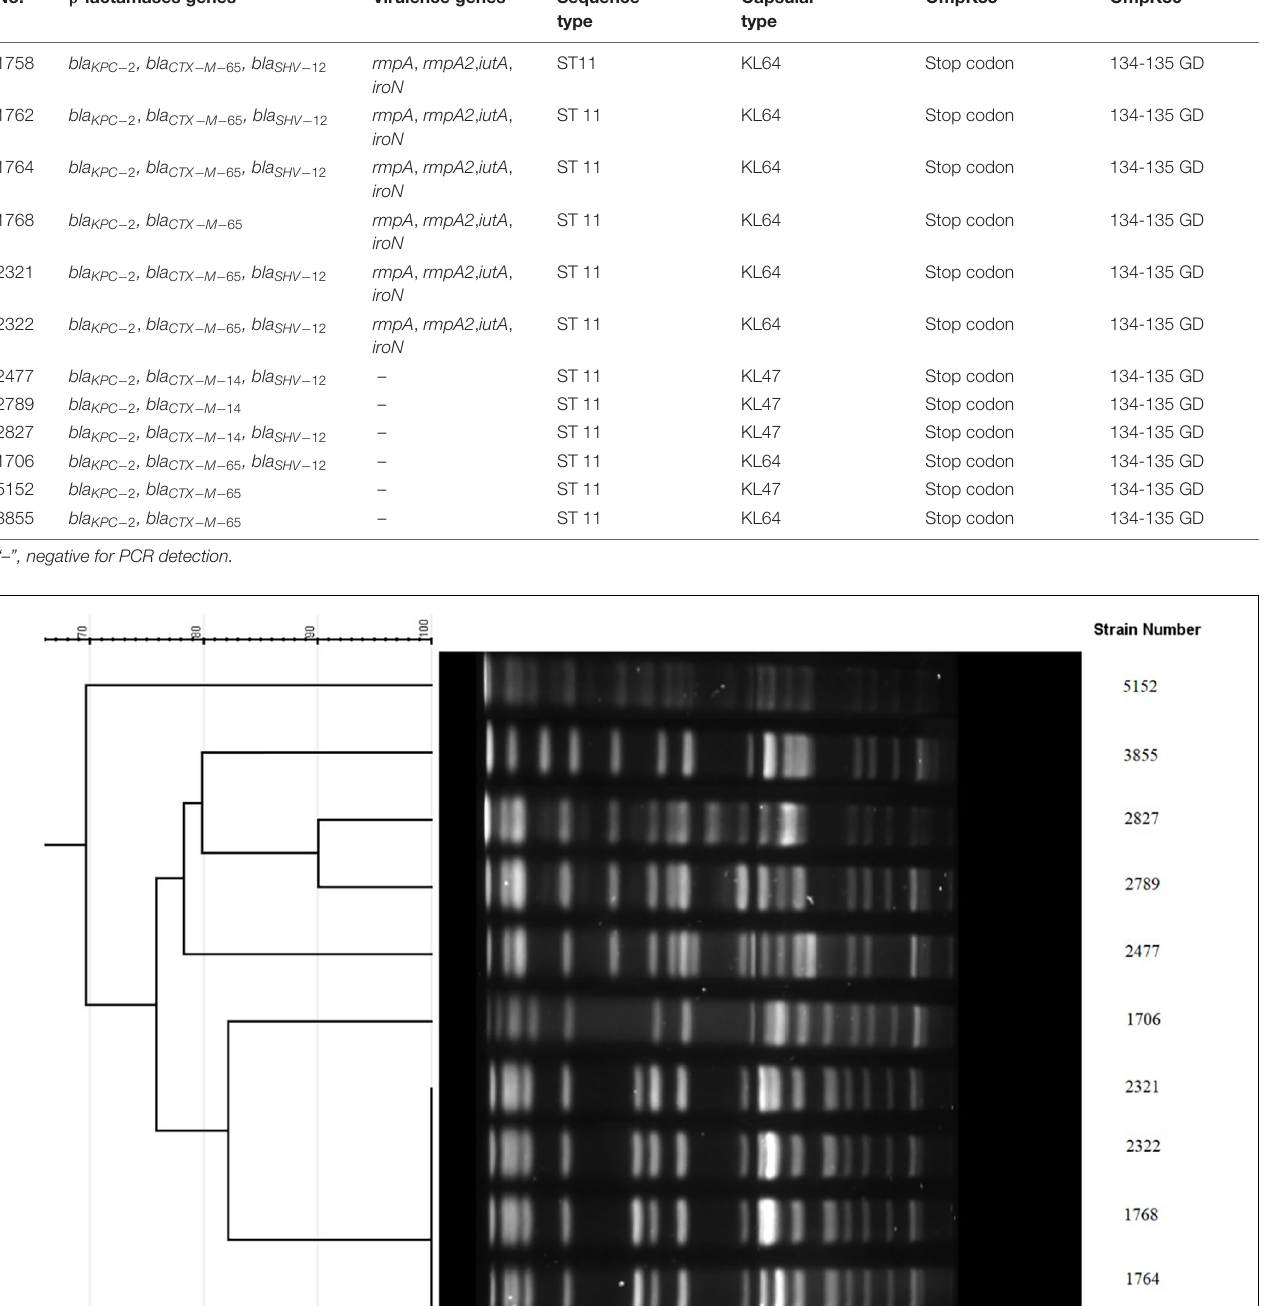
TABLE 4 | Molecular characteristics of the 12 KPC-KP with reduced susceptibility to ceftazidime-avibactam. No.